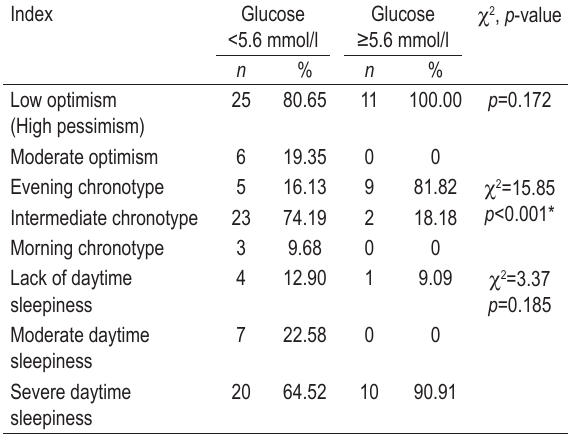
TABLE 6. Frequency of hyperglycemia registration according to criteria of metabolic syndrome in patients with arterial hypertension depending on dispositional optimism, chronotype, and level of